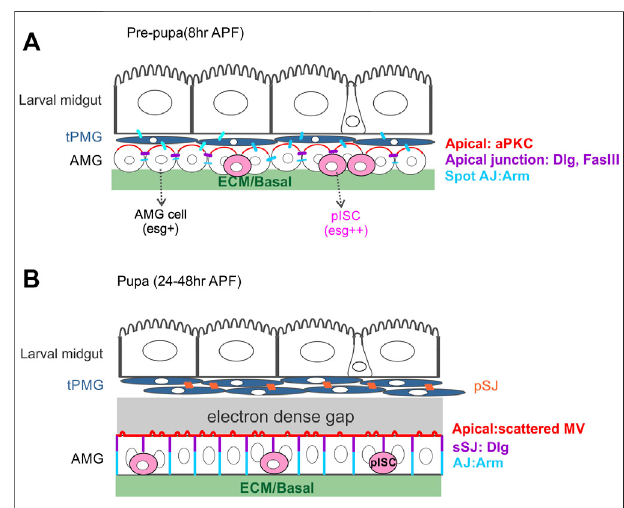
FIGURE 4 | The organisation of the midgut during pupal development. (A) During the fi rst hours after puparium formation, the peripheral cells of late larval midgut AMP nests re-arrange to form the tPMG (dark blue) around the degenerating larval midgut cells. At the onset of metamorphosis, the centralcells of late larval midgut AMPnestsspreadout to surround the tPMG. ThislayerofAMPcellsinitiallyexpress esg homogenously,butmostAMGcells downregulate esg as they differentiate into ECs. A subset of AMPs maintain esg expression and become the presumptive intestinal stem cells (pISCs, pink),theprecursorsoftheadultintestinalstemcells.Atthisstage, aPKC(red) localises to the apical domain of the AMG cells and Dlg and FasIII to the apical side of the lateral domain (purple). Spot AJs (blue) connect the larval ECs, the tPMGandtheAMGcells. (B) From20 hAPFonwards,thetPMGappearsasa tightly packed multi-layered structure with pleated SJs (orange) connecting the cells. By this stage, the tPMG has separated from the surrounding AMG and an electron dense liquid can be found between the twotissues. The AMG starts to develop irregularly spaced apical microvilli and smooth SJs at the apicalsideofthelateralmembrane.AJsconnectthemorebasalregionsofthe lateral membrane. pISCs remain basally